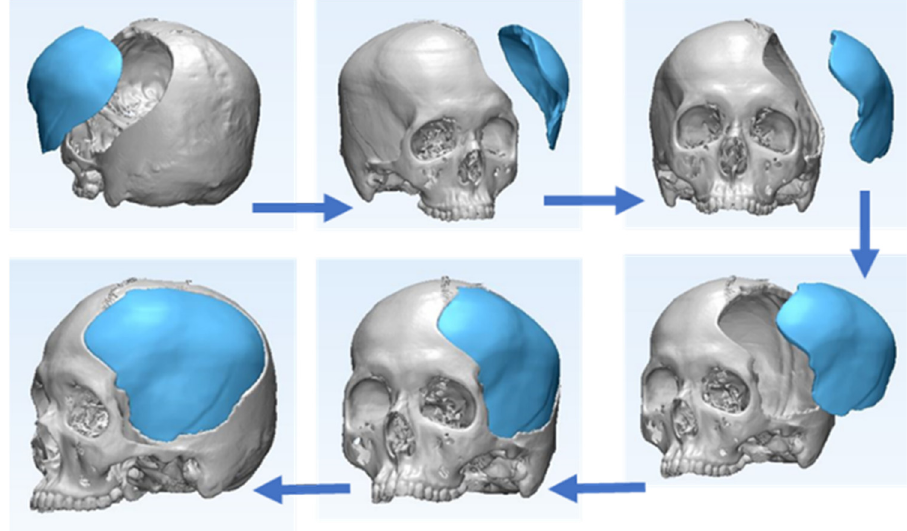
Figure 1. Fitting evaluation of patient-specific cranial implant on the defect skull.